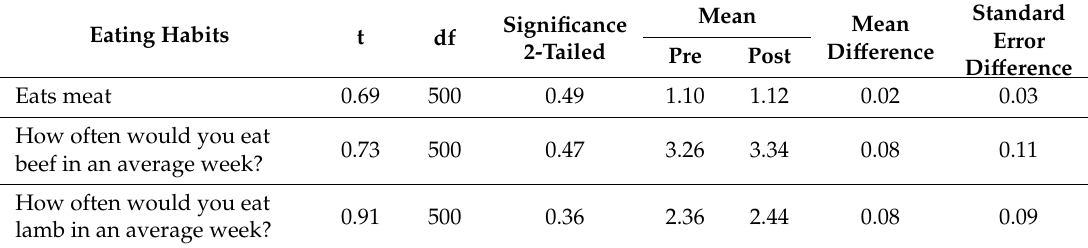
Table 5. Independent t-tests comparing the eating habits of respondents completing the survey prior to vs post the 60 Minutes Programme.